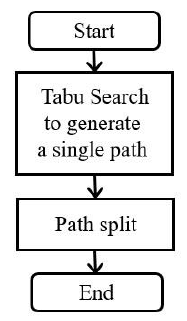
Figure 4. Establishment of the Initial Solution.